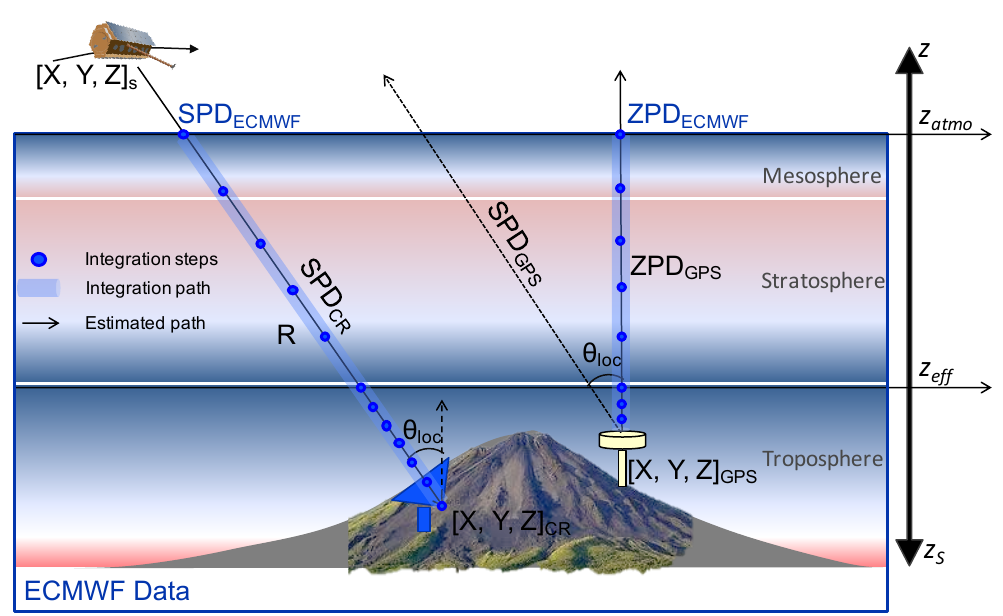
Figure 1. Sketch of validation methods. Types of delay measurements: (1) ZPD from GPS measurements (ZPD GPS ) estimated at the GPS coordinates [ X , Y , Z ] GPS and SPD projected with the local incidence angle θ loc (SPD GPS ); (2) SPD from CR measurements (SPD CR ) at the CR coordinates [ X , Y , Z ] CR ; (3) integrated ECMWF delays: ZPD ECMWF at